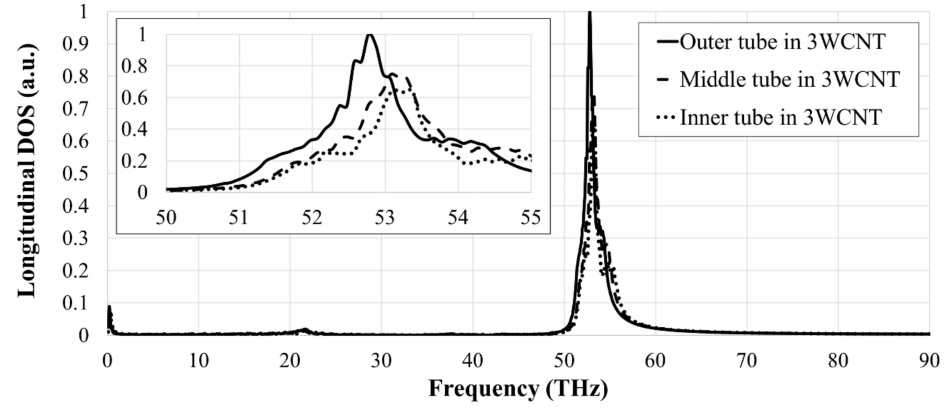
Figure 4. Normalized PDOS curves for each tube in a 3WCNT. The inset shows the curves for the frequency of 50–55